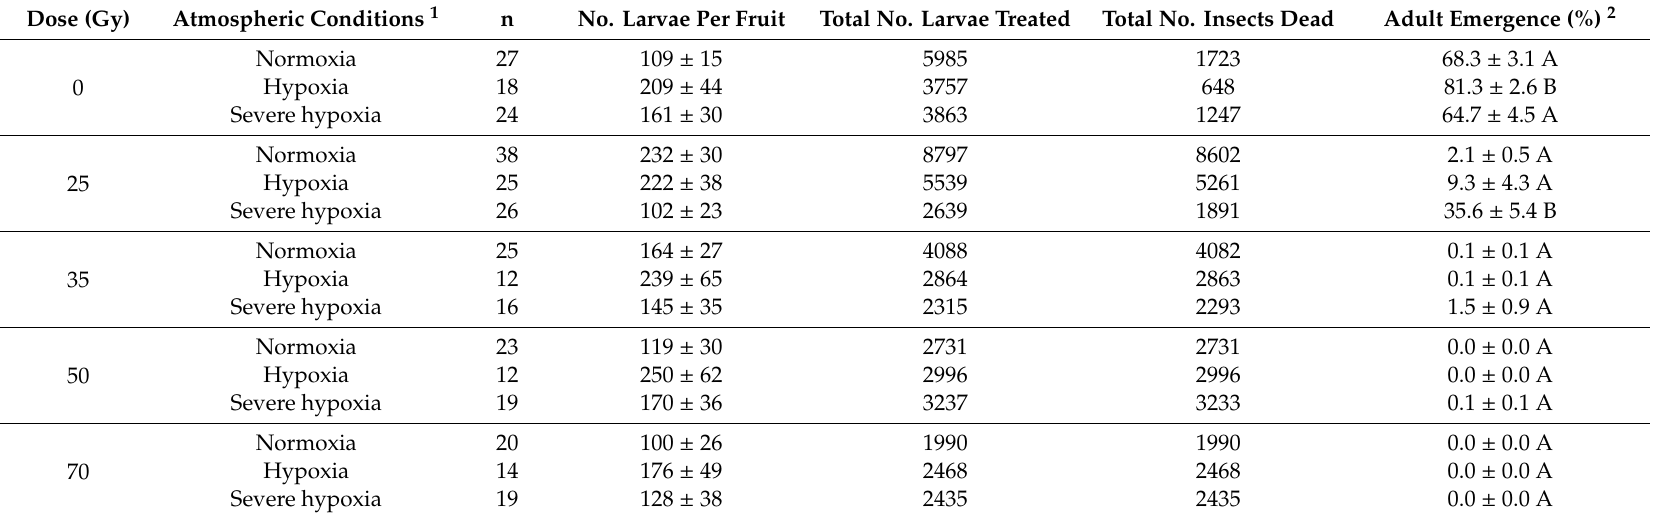
Table 2. Numbers of replicates, larvae per fruit (mean ± SE), treated larvae, dead insects, and adult emergence (mean ± SE) of Anastrepha ludens third instars irradiated at di ff erent nominal doses and atmospheric